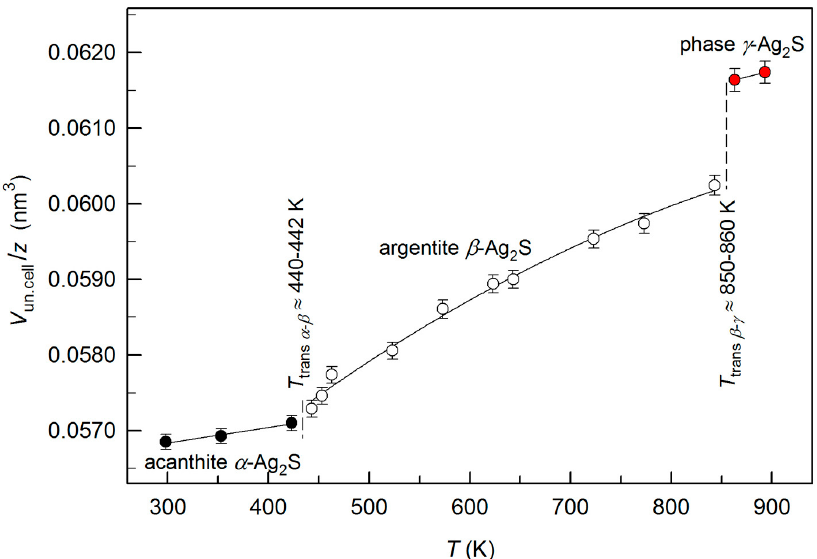
Figure 10. Temperature dependence of reduced volume V un.cell / z of silver sulfide in the region 298–893 K. At ~440–442 K and ~850–860 K, jumps in the reduced volume are observed, which cor- respond to the first order phase transformations “ α -Ag 2 S— β -Ag 2 S” and “ β -Ag 2 S— γ -Ag 2 S”, respec- tively. The change in the reduced volume upon the “ α -Ag 2 S acanthite— β -Ag 2 S argentite” transition is noticeably less than that during the “ β -Ag 2 S argentite— γ -Ag 2 S phase” tran- sition. The small value of the jump in the reduced volume at the transition “ α -Ag 2 S acanthite— β -Ag 2 S argentite” is due to the following. According to [57], the structure of α -Ag 2 S acanthite is a result of small displacements of S and Ag atoms from positions of bcc lattice of β -Ag 2 S argentite. The “acanthite—argentite” transformation occurs due to